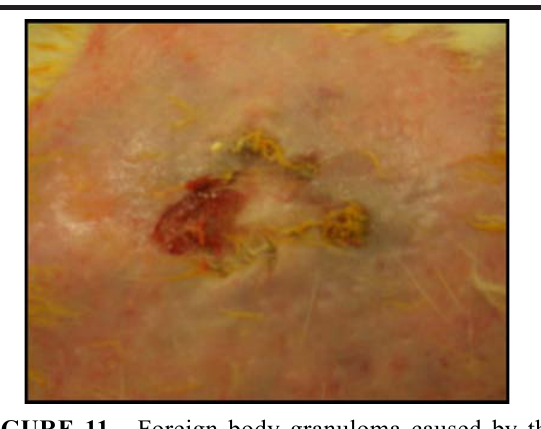
FIGURE 11 - Foreign body granuloma caused by the polypropylene mesh on the abdominal wall.